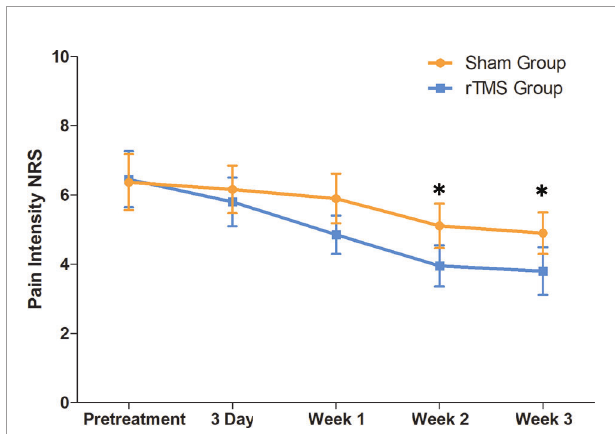
FIGURE 3 | Raw scores on primary outcome (NRS) from baseline to 3 weeks. The NRS scores were calculated by the average for the preceding 7 days. Error bars indicate 95% con fi dence intervals, * indicate signi fi cant inter- group difference, P < 0.05. NRS, numeric rating scale.